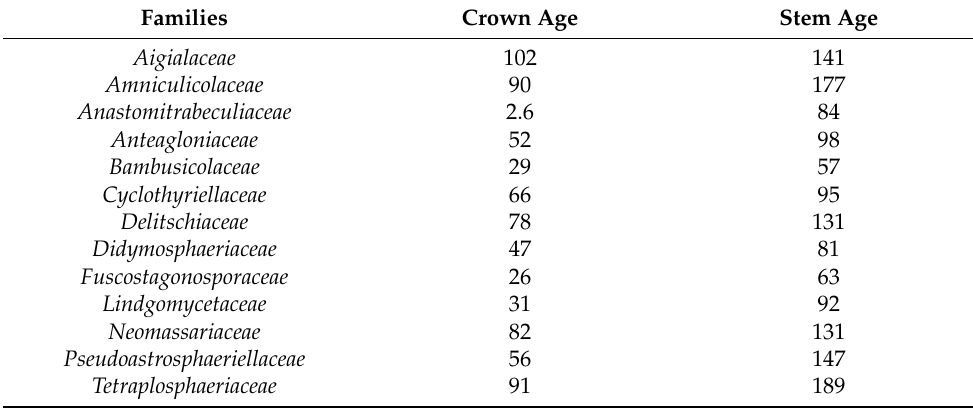
Table 3. Divergence time estimates obtained from BEAST analysis for families with similar mor- phology to Anastomitrabeculiaceae . The crown age and the stem age are provided in million years ago